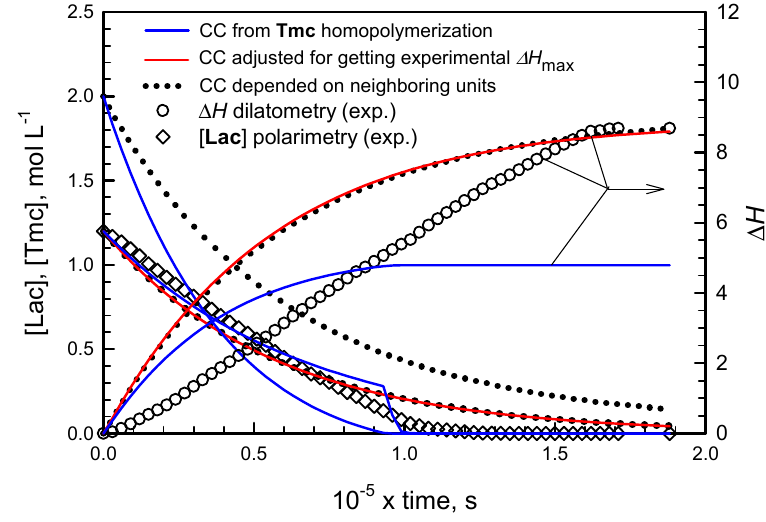
Figure 1. Fitting of simulated changes of [ Lac ] (lines starting from [ Lac ] = 1.2) and of the dilatometer meniscus height Δ H (lines starting from Δ H = 0) to experimental data (diamonds: [ Lac ], circles: meniscus Δ H ) for copolymerization of Lac with Tmc , initiated with [ S - Ini ] = 2 × 10 − 3 (+[ i PrOH] 0 = 4 × 10 − 3 mol · L − 1 due to in situ synthesis of Ini ), [ Lac ] 0 = 1.2, [ Tmc ] 0 = 2 mol · L − 1 . Blue lines: volume contraction coefficient (CC) for Tmc copolymerization equal to that determined from homopolymerization experiments, red lines: CC for Tmc units increased to get the same final meniscus height as determined experimentally, black dot lines: Tmc and Lac unit CC depending on neighboring units, as determined in our studies (see Supporting Information). Additionally the predicted changes of [ Tmc ] are presented (lines starting from [ Tmc ] =